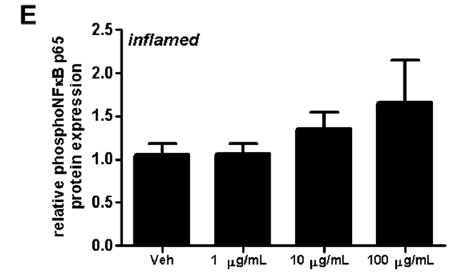
Figure 10. Effect of fullerenols on erk1/2 and NF κ B signaling in mouse brain microvascular endothelial cell (MBMEC) cultures exposed to basal or inflammatory conditions. Western blot analyses and densitometric quantification (normalized to basal or inflamed untreated control cell cultures) of the amount of erk1/2 and phospho-erk1/2 proteins ( A – C ) in MBMEC treated for 60 min with fullerenols (F; 1, 10 and 100 µg/mL; n = 5) and exposed to interferon- γ and tumor necrosis factor- α (I + T; 100 IU each) ( C ) compared with fullerenol-treated cultures in basal milieu ( B ). Western blot analyses and densitometric quantification (normalized to basal or inflamed untreated control cell cultures) of the amount of NF κ B p65 and phospho NF κ B p65 proteins in MBMECs treated for 60 min with fullerenols (F; 1, 10 and 100 µg/mL; n = 4) and exposed to interferon- γ and tumor necrosis factor- α (I + T; 100 IU each) ( D , E ). Ctrl, untreated control; Veh, vehicle treatment; * p < 0.05; ** p < 0.01.